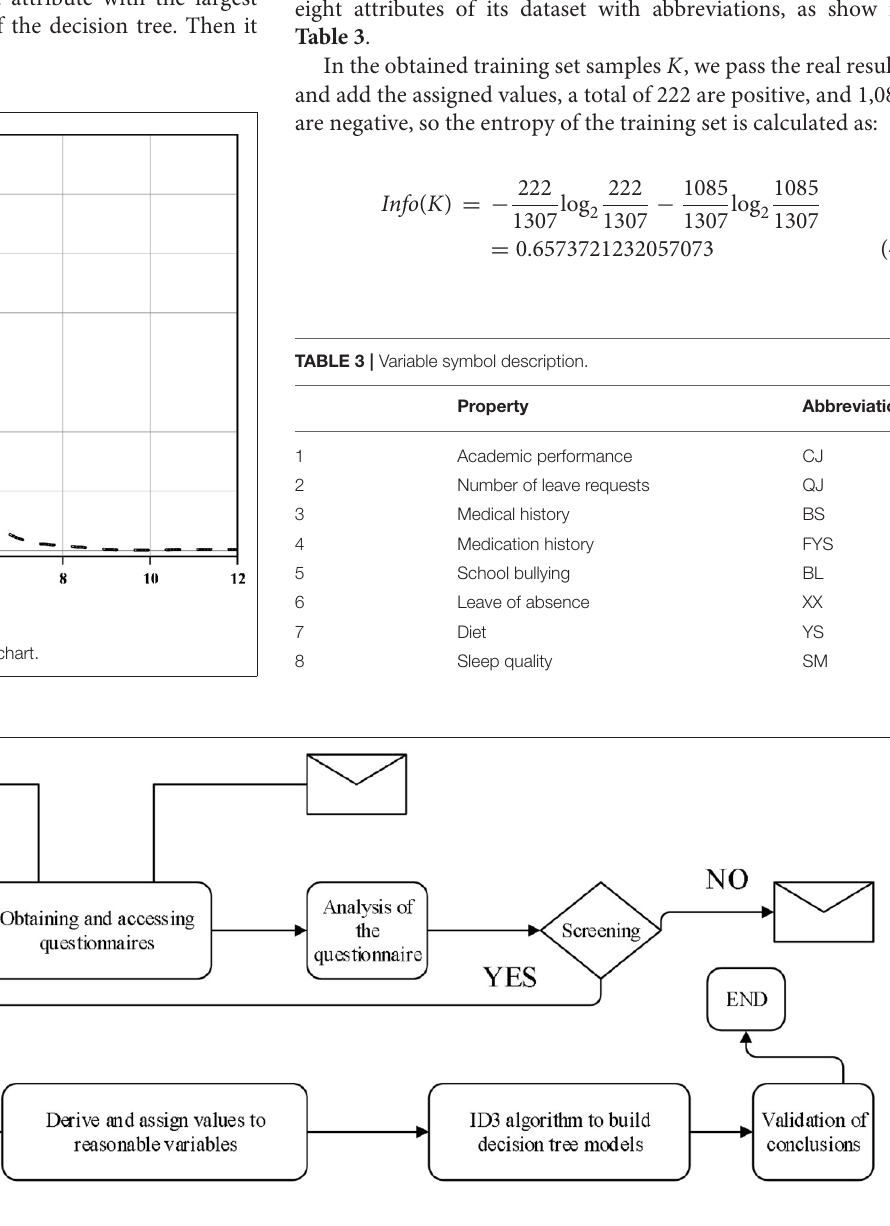
FIGURE 3 | Research idea flow